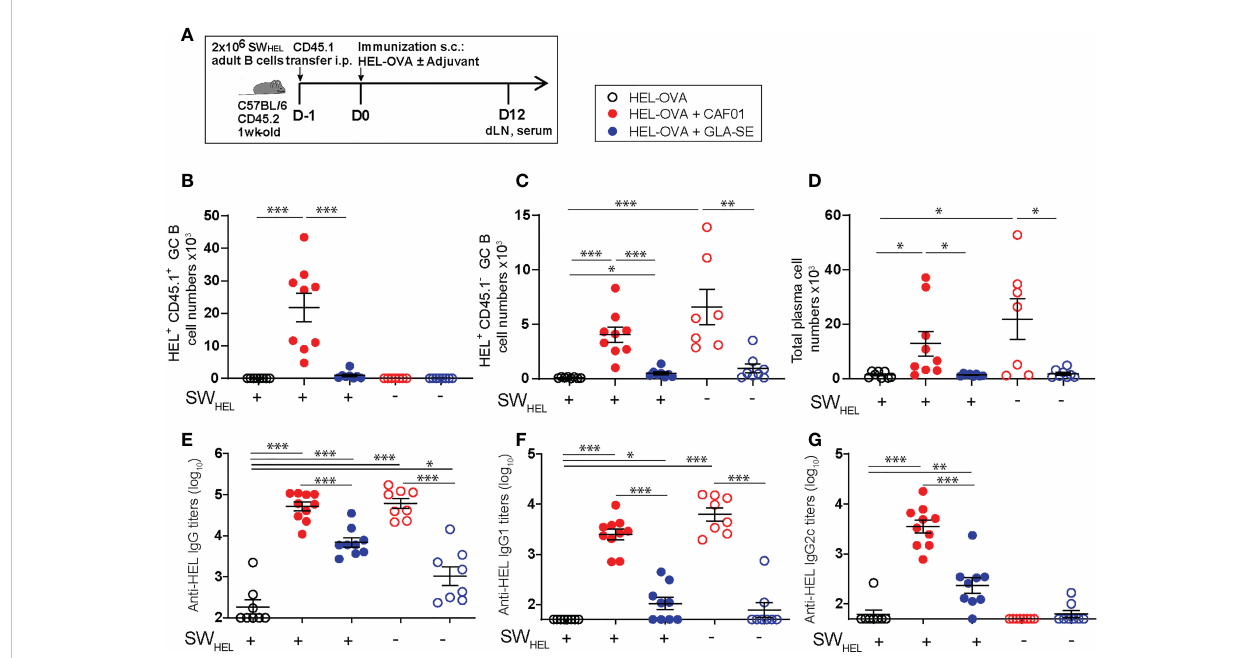
FIGURE 7 The initiation of neonatal GC reactions requires fully functional Tfh cells. (A) Experimental schedule of the adult SWHEL B cells adoptive transfer. Naïve congenic 1-week old C57BL/6 recipient mice received each 2 x 10 6 adult CD45.1 + B cells by intraperitoneal injection. Recipient and control neonatal mice were immunized s.c. the following day with 20 µg HEL-OVA formulated in CAF01, GLA-SE or PBS as control. Serum samples and inguinal draining LNs were collected 12 days post immunization. (B – D) The formation of HEL-speci fi c GCs and plasma cells was measured by fl ow cytometry in the draining LNs of immunized neonates; graphs show the number of (B) SWHEL HEL + CD45.1 + GL7 + CD95 + GC B cells, (C) endogenous HEL + CD45.1 - GL7 + CD95 + GC B cells, and (D) total frequencies of B220int/lowCXCR4 + CD138 + PCs. (E-G) HEL-speci fi c serum (E) IgG, (F) IgG1, and (G) IgG2c titers were measured by ELISA. Dots show values per individual mouse (N ≥ 6 per group) whereas black bars indicate means ± SEM. Statistical analysis were performed using the Mann-Whitney U test: * P <0.05, ** P <0.01, *** P <0.001, **** P <0.0001. Data were pooled from at least two independent